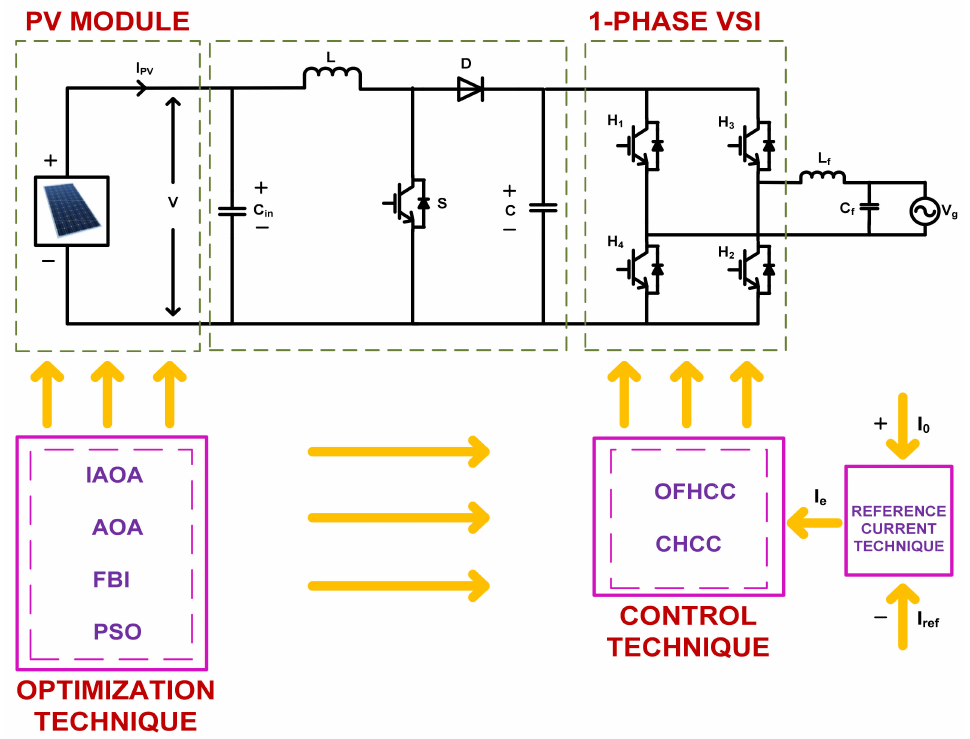
Figure 2. System block